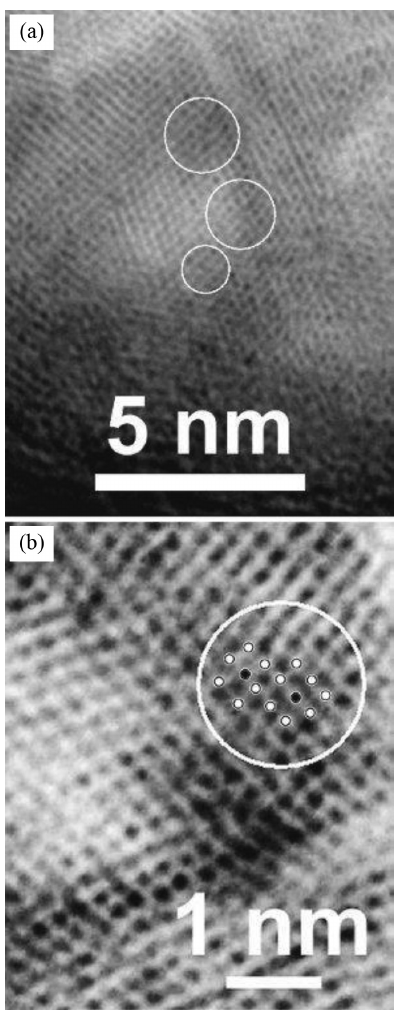
Figure 7. High-resolution TEM images of the Al glassy alloy in as-solidified state 27 .